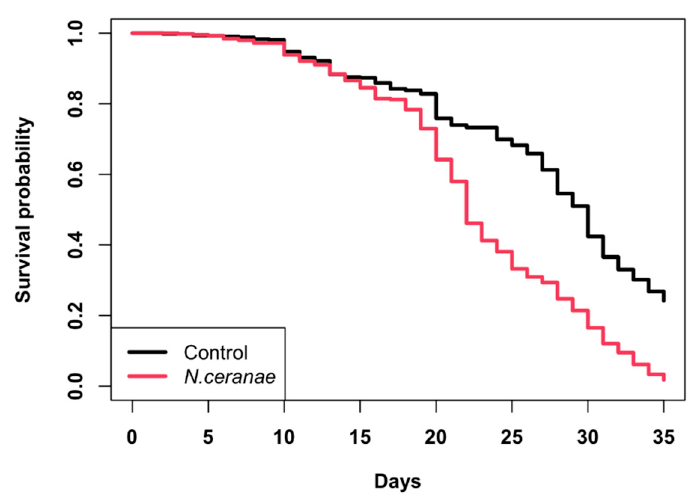
Figure 2. Probability of survival of adult worker honey bees inoculated with 50,000 Nosema ceranae spores / bee (red) or not inoculated (black) when newly emerged. Experimental bees were marked, introduced into colonies and daily censed. Survival functions were estimated with the Kaplan-Meier method.